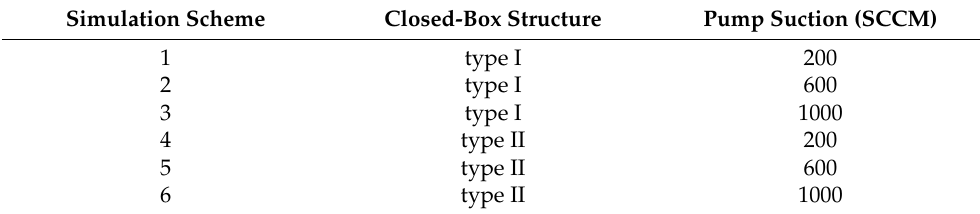
Table 1. Simulation scheme.